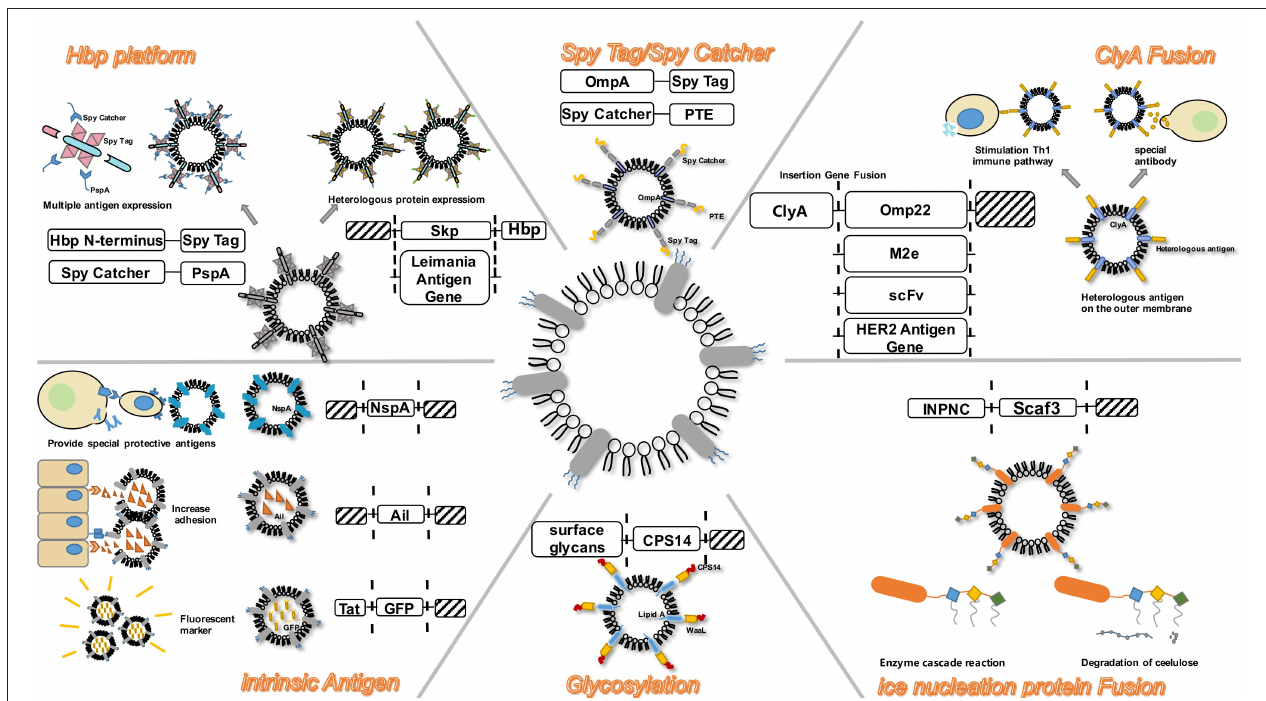
FIGURE 2 | OMV serves as a versatile transformation platform. Engineering methods include: ClyA Fusion; Spy Tag/Spy Catcher; Hbp platform; intrinsic antigen; Glycosylation; Ice nucleation protein